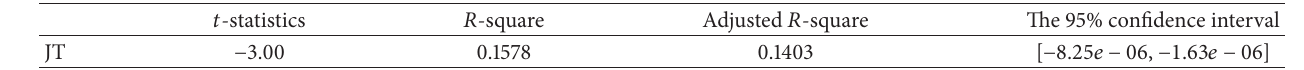
Table 6: Statistical parameters of JT on MQ.